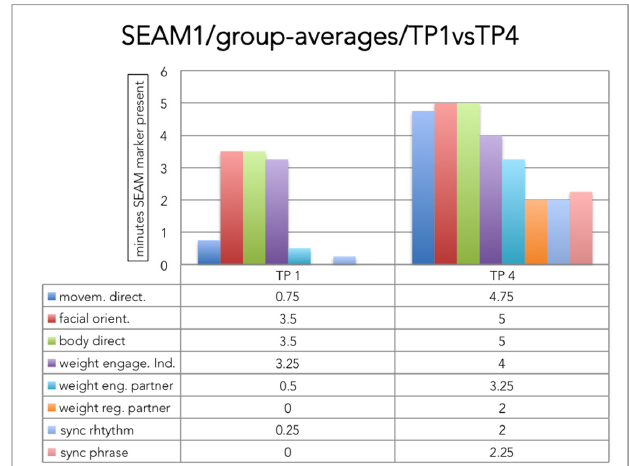
Figure 1. To show a graphical summary of differences in the average group SEAM profile between the start and end of dance movement therapy (DMT). The SEAM categories are presented in columns; the height of the columns indicates the average number of minutes that a SEAM behavior was present during the observed five minutes’ samples